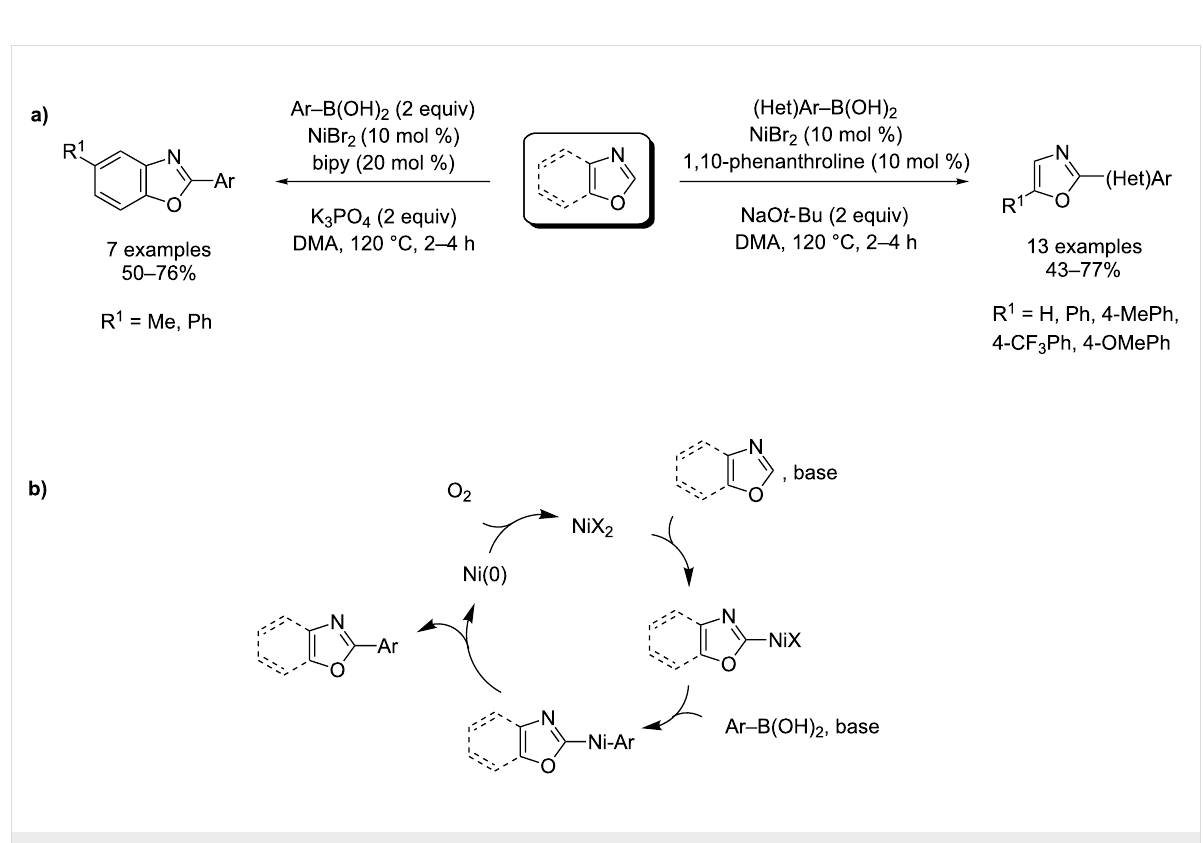
Scheme 28: Ni(II)-catalyzed direct arylation of benzoxazoles with arylboronic acids under O 2 [76]; (a) procedure; (b) proposed